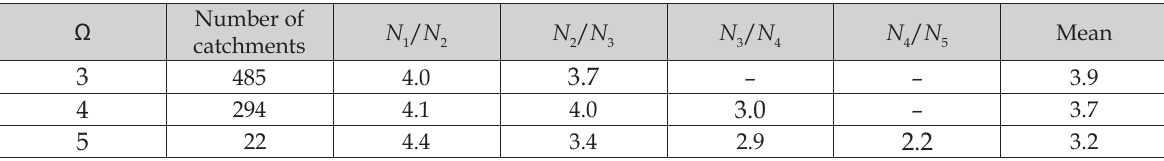
) in catchments where “the law of stream number” was fulfilled i